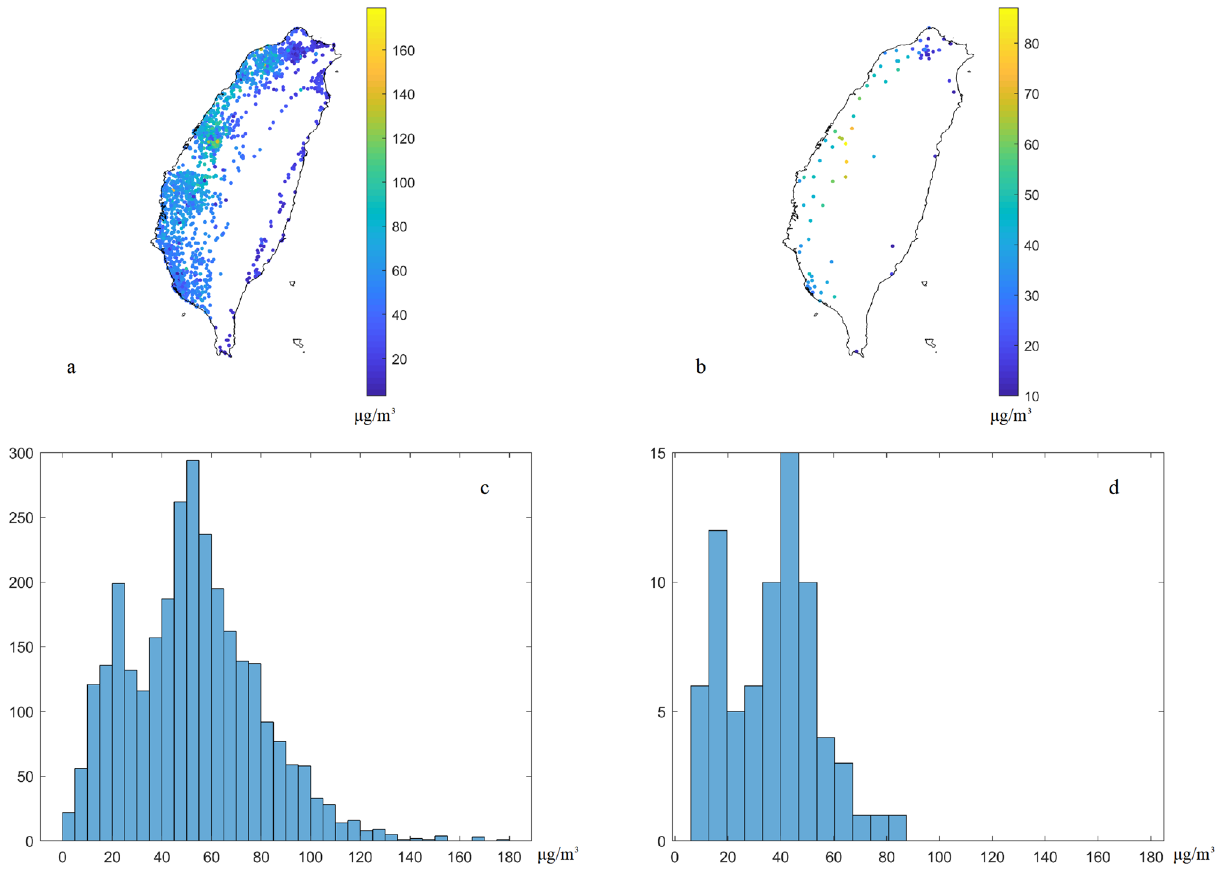
Figure 3. Raw PM 2.5 concentrations from ( a ) low-cost sensors and ( b ) regulatory stations and their histograms ( c , d ) in the case study. The plots were created in MATLAB_R2018B (https ://www.mathw orks.com/produ cts/ matla